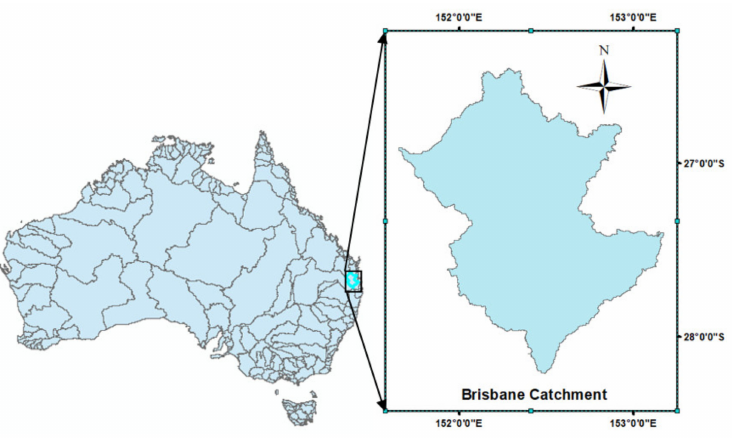
Figure 1. Study area.